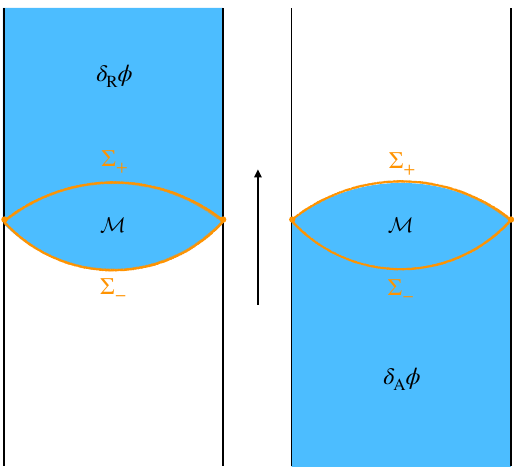
Figure 6 . Illustration of the retarded and advanced solutions in the Peierls construction. The action is deformed by the functional W in the bulk region M , which lies between the two surfaces denoted Σ (i.e., the two orange curves). The blue shading shows the support of the retarded ± solution δ φ in the left panel, and that of the advanced solution δ R